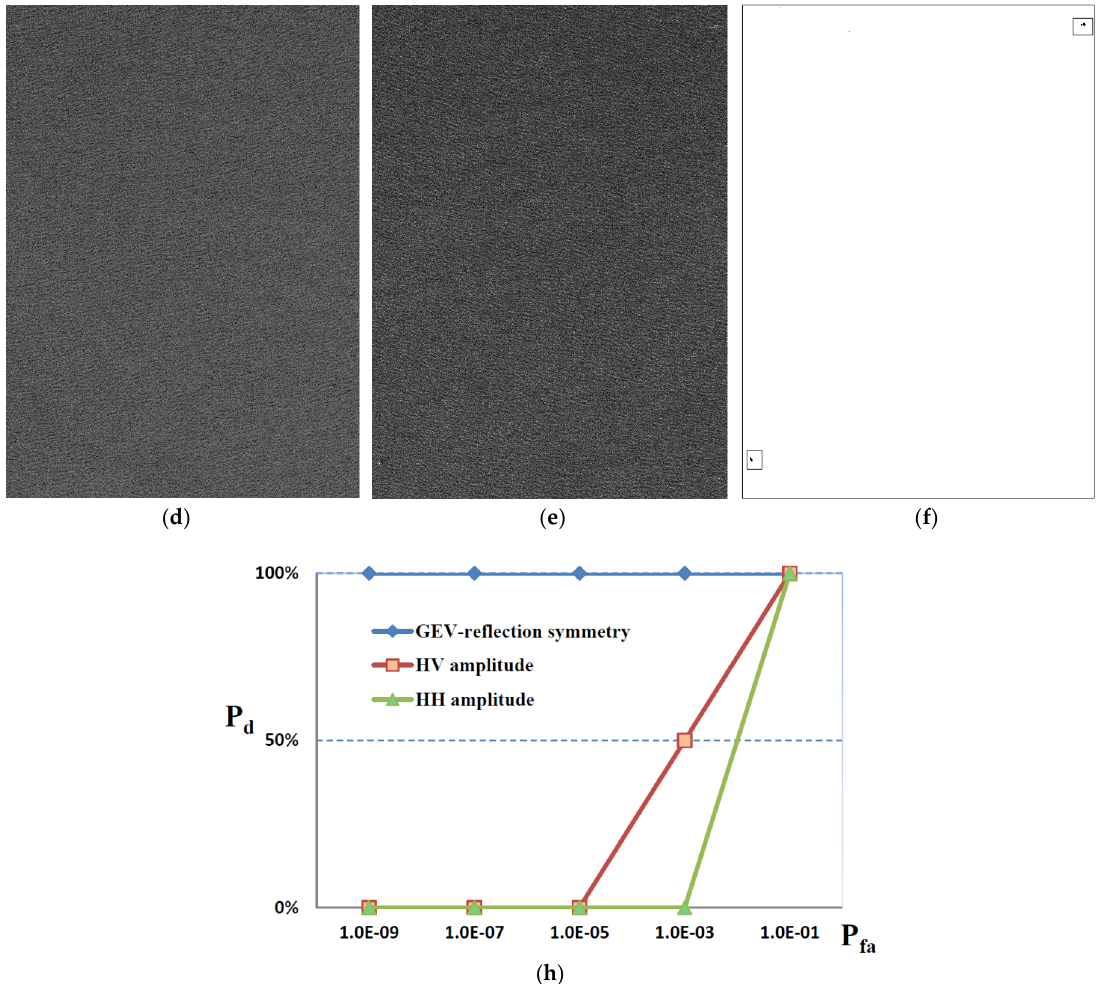
Figure 13. ( a ) VH amplitude; ( b ) HH amplitude; ( c ) reflection symmetry metric; ( d ) polarimetric entropy; ( e ) polarimetric scattering angle; ( f ) detection result; ( h ) detection results comparison with ROC curves.